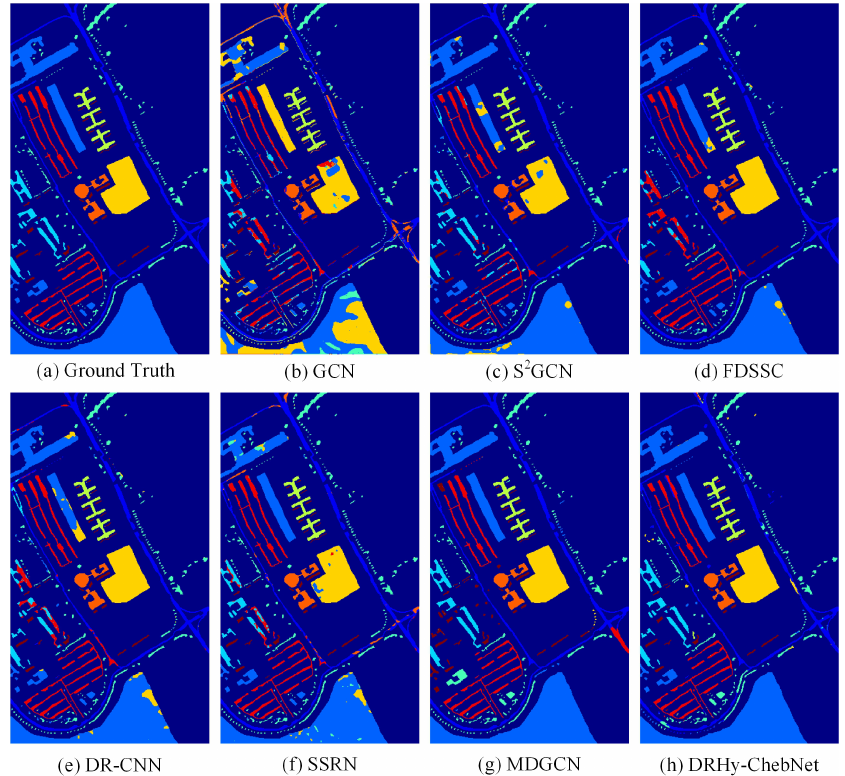
Figure 5. Classification results of different methods on the University of Pavia dataset. ( a ) Ground truth. ( b ) GCN. ( c ) S 2 GCN. ( d ) FDSSC. ( e ) DR-CNN. ( f ) SSRN. ( g ) MDGCN. ( h ) The proposed DRHy-ChebyNet